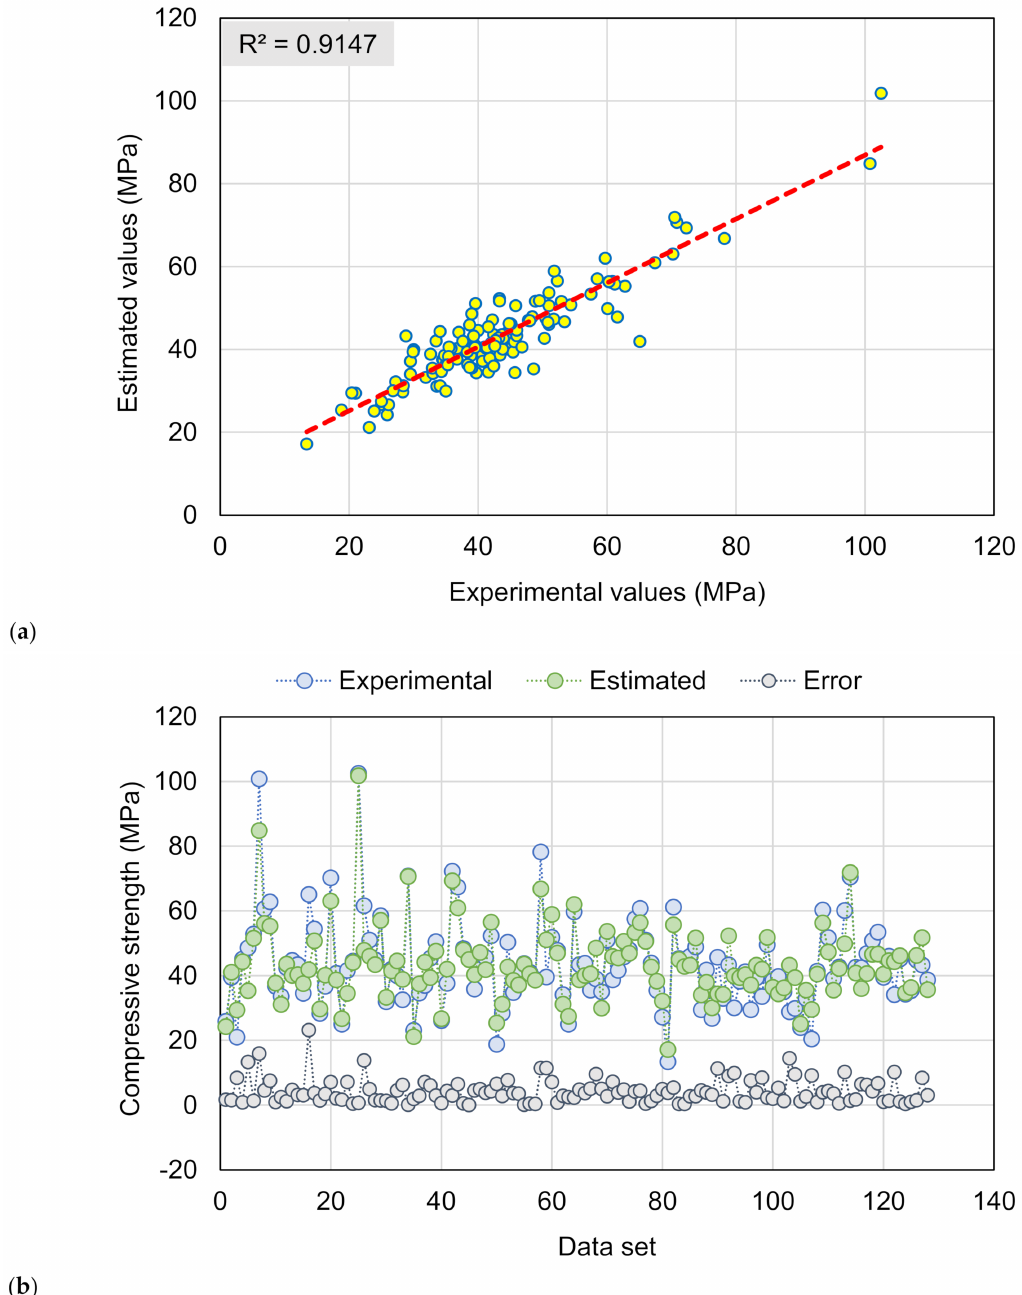
Figure 8. Bagging regressor model: ( a ) Relationship among experimental and forecasted results; ( b ) Scattering of actual and predicted